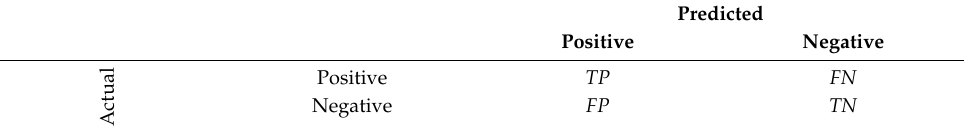
Table 3. Confusion